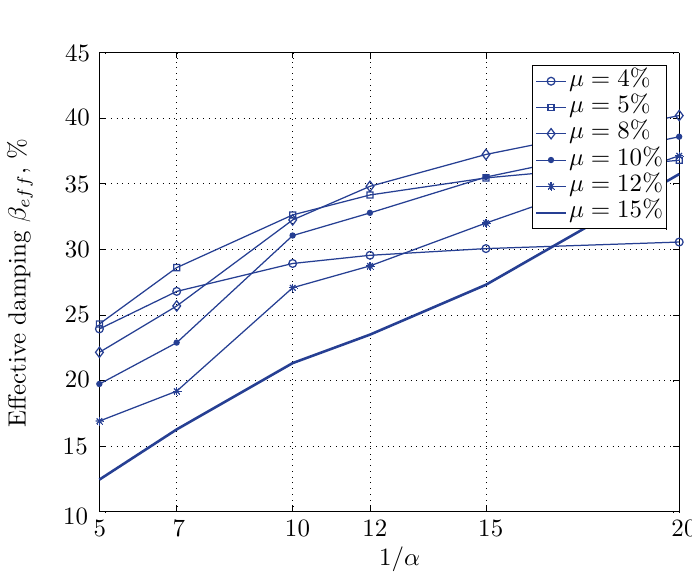
Figure 28. Effective damping for various isolation system parameters